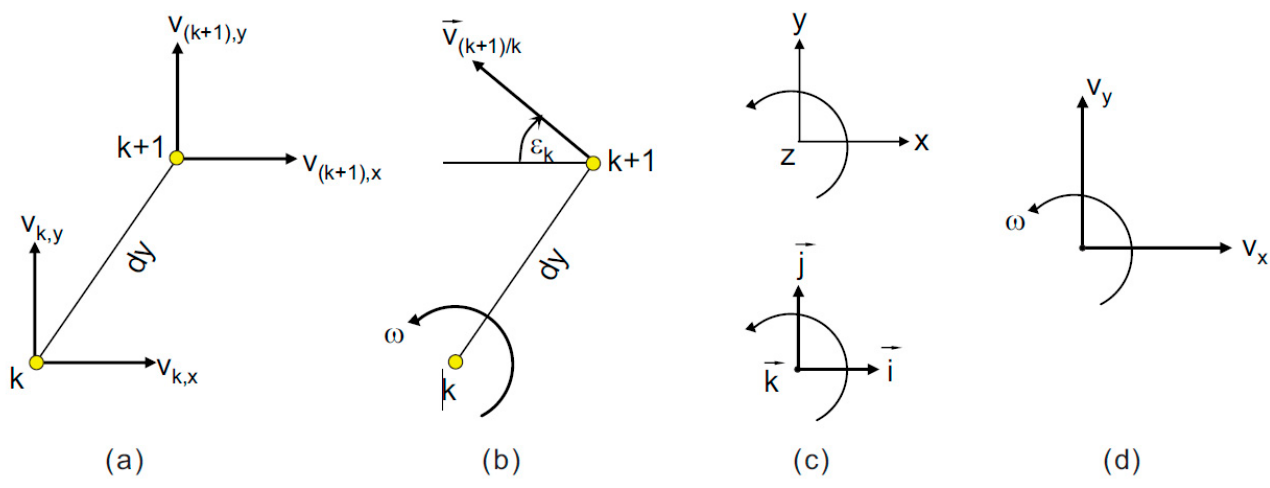
Figure 9. The connecting element between two points, k and k + 1.